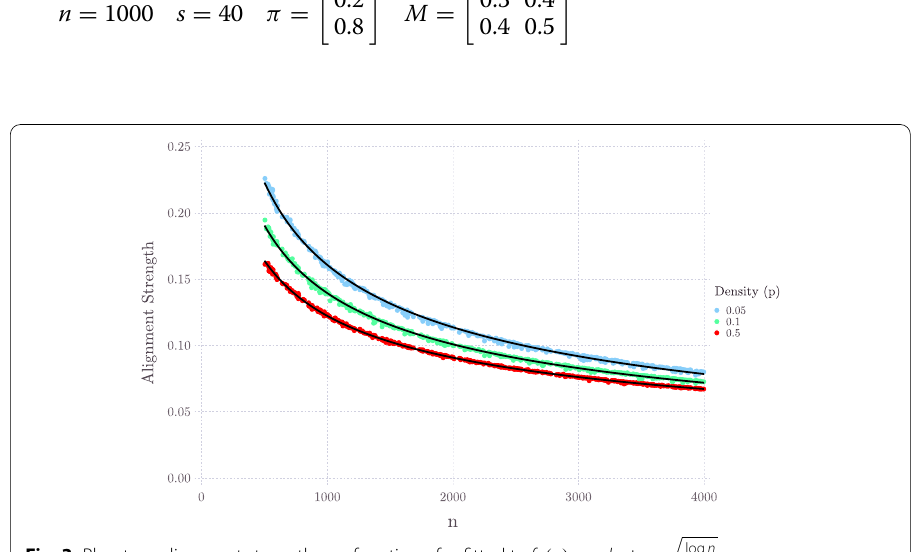
Fig. 3 Phantom alignment strength as a function of n , fitted to f p ( n ) := d p + c p